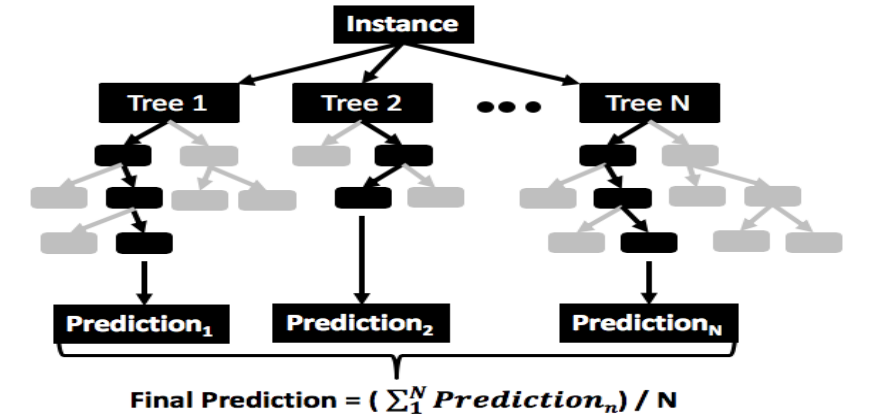
Figure 2. Illustration of the random forest (RF) where the final prediction is the average of the predictions of each tree in the